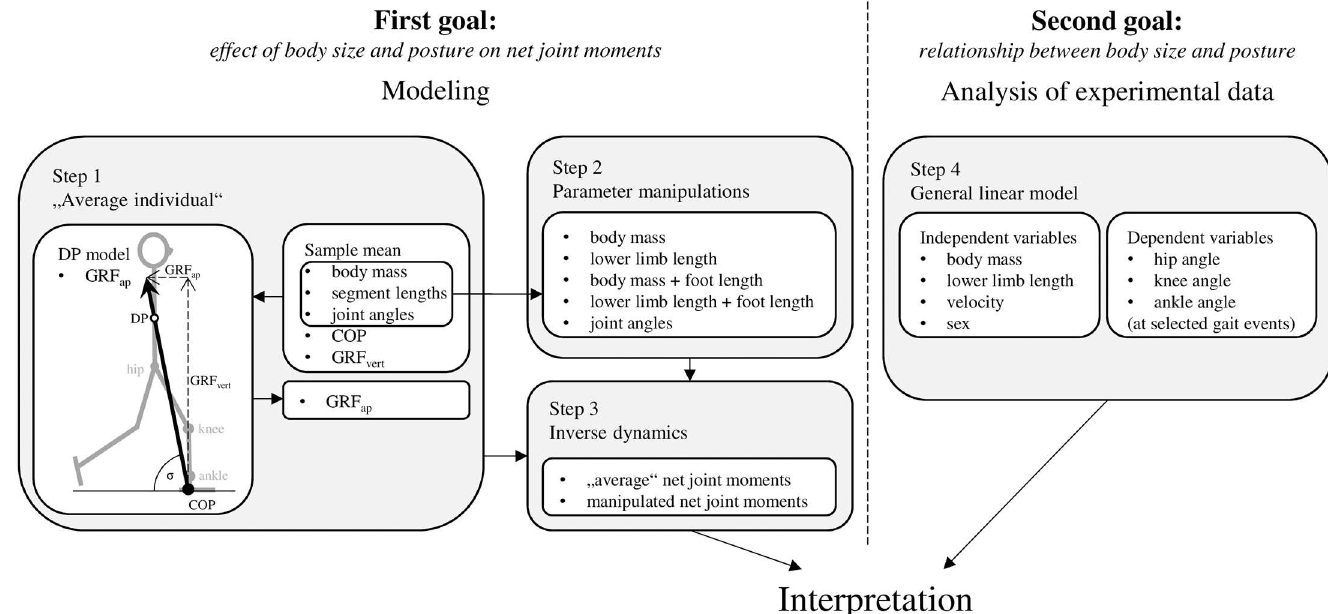
Fig 1. Schematic diagram of the approaches used to accomplish the goals of this